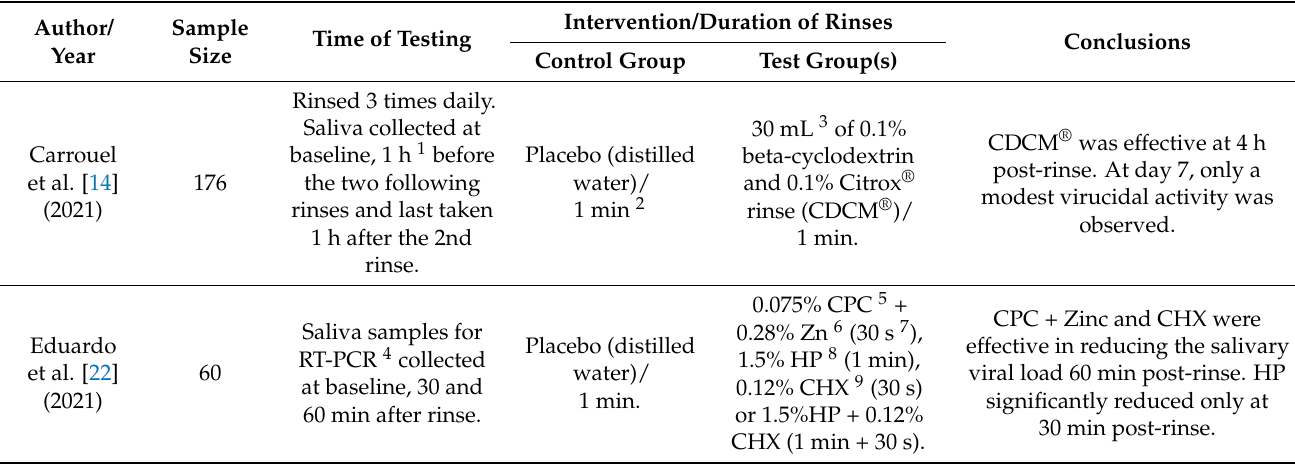
Figure 1. PRISMA ® flow diagram of the search processes and results. Table 1. Results of the included